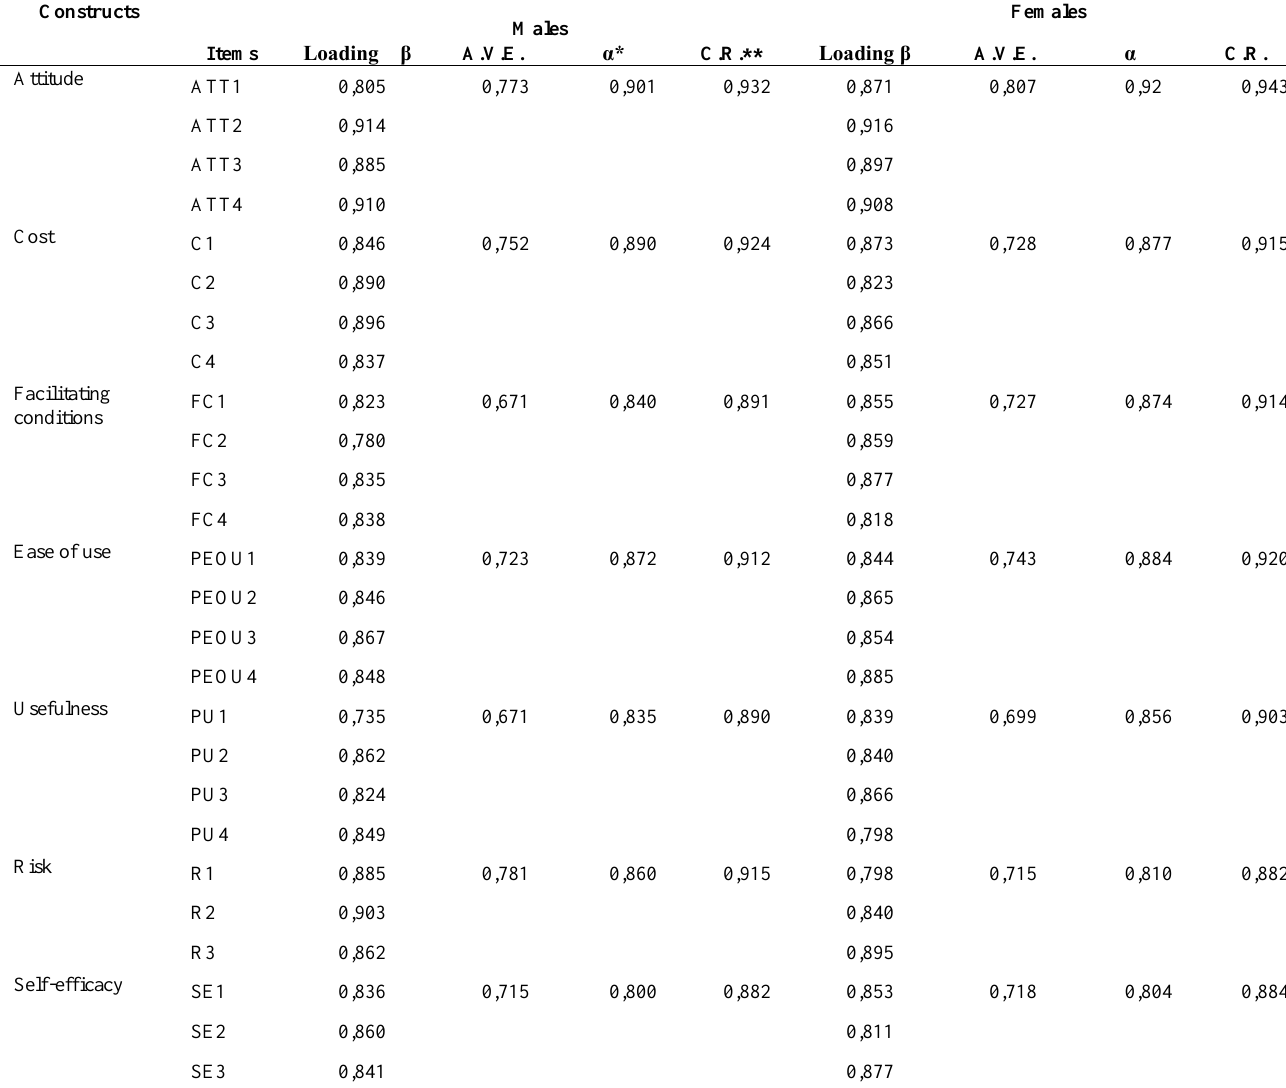
Table 2: Construct reliability and convergent